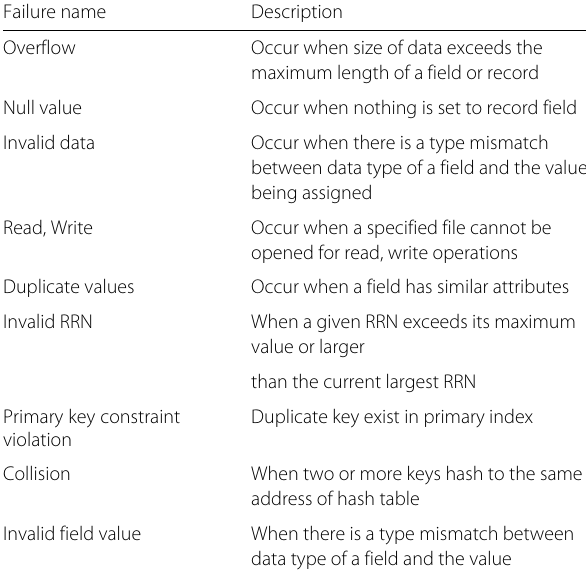
Table 4 List of possible failures and their description